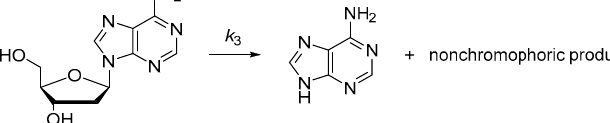
Scheme 3. Depurination of 2 (cid:48) -deoxyadenosine.